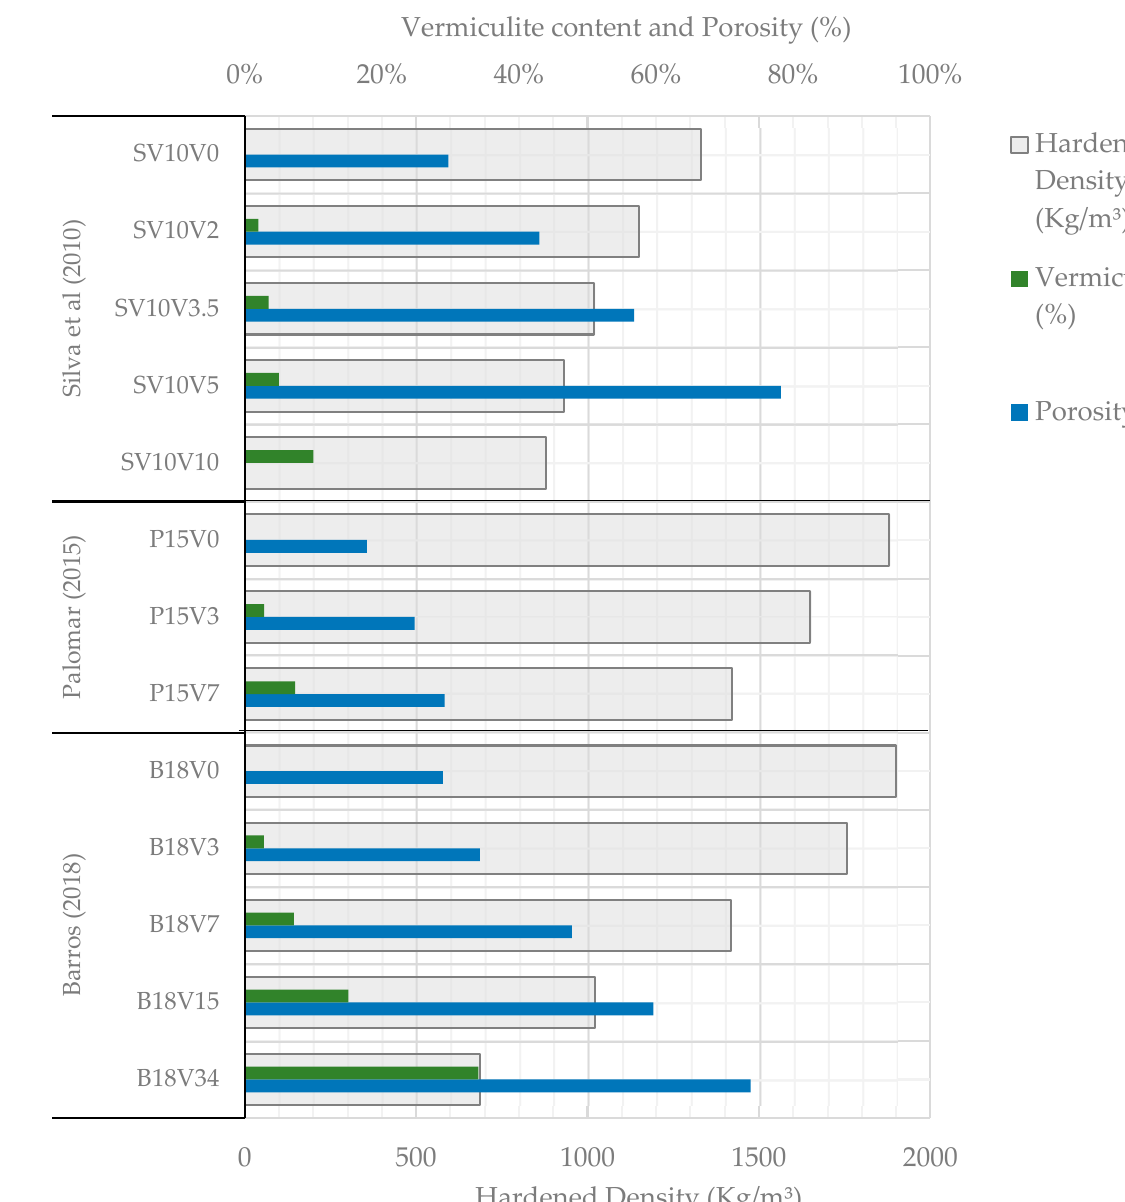
Figure 7. Correlation of the porosity, hardened density, and vermiculite content [17,41,44]. Barros (2018) [17] presented mortars with vermiculite contents of 0%, 3%, 7%, 15%,